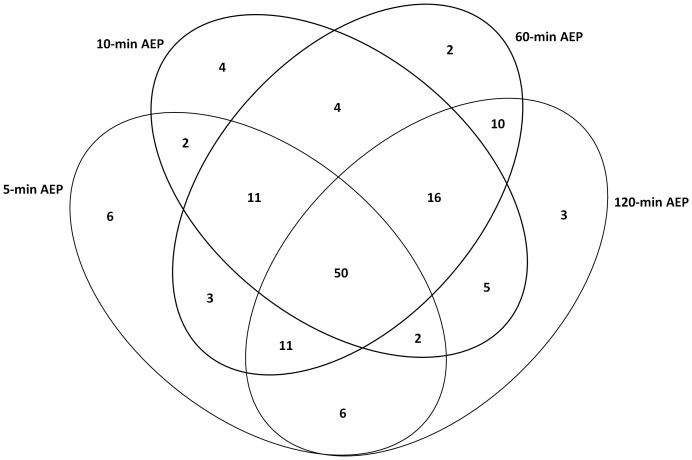
Venn diagram of AEP proteins identified in each time-point and across time-point.